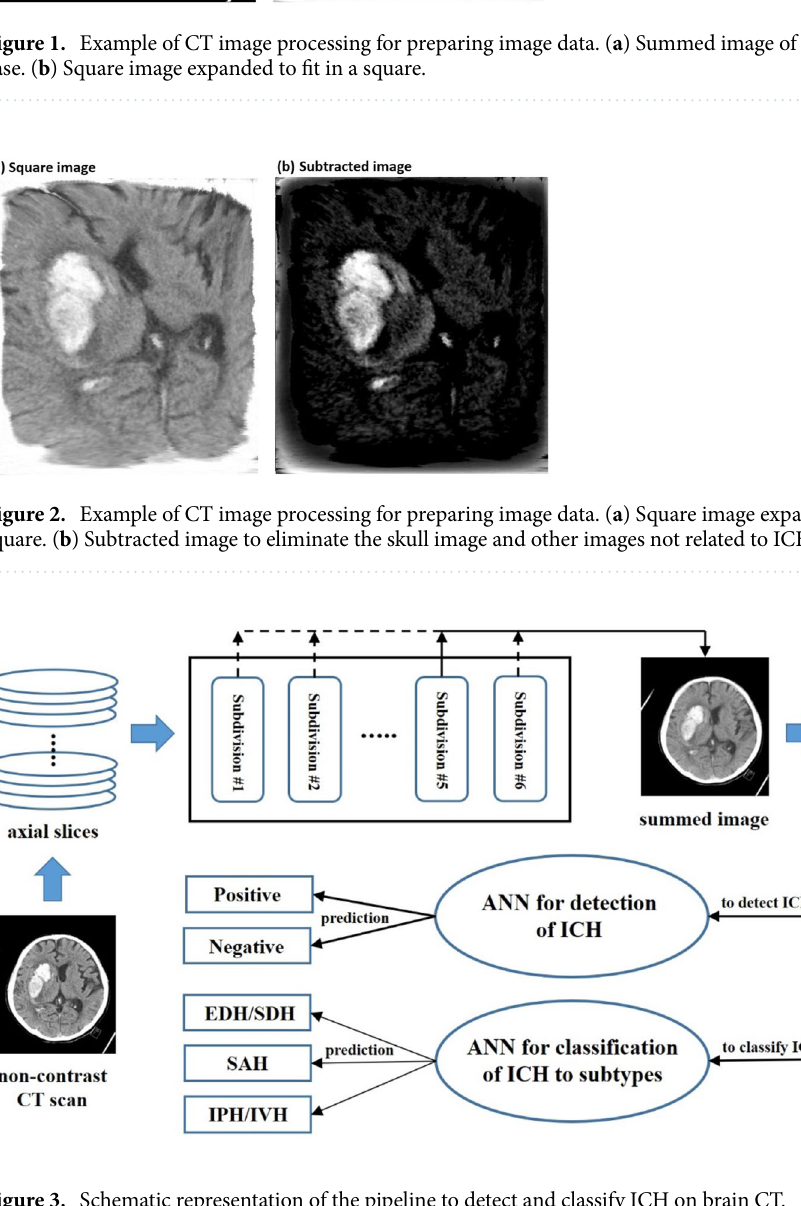
Figure 3. Schematic representation of the pipeline to detect and classify ICH on brain